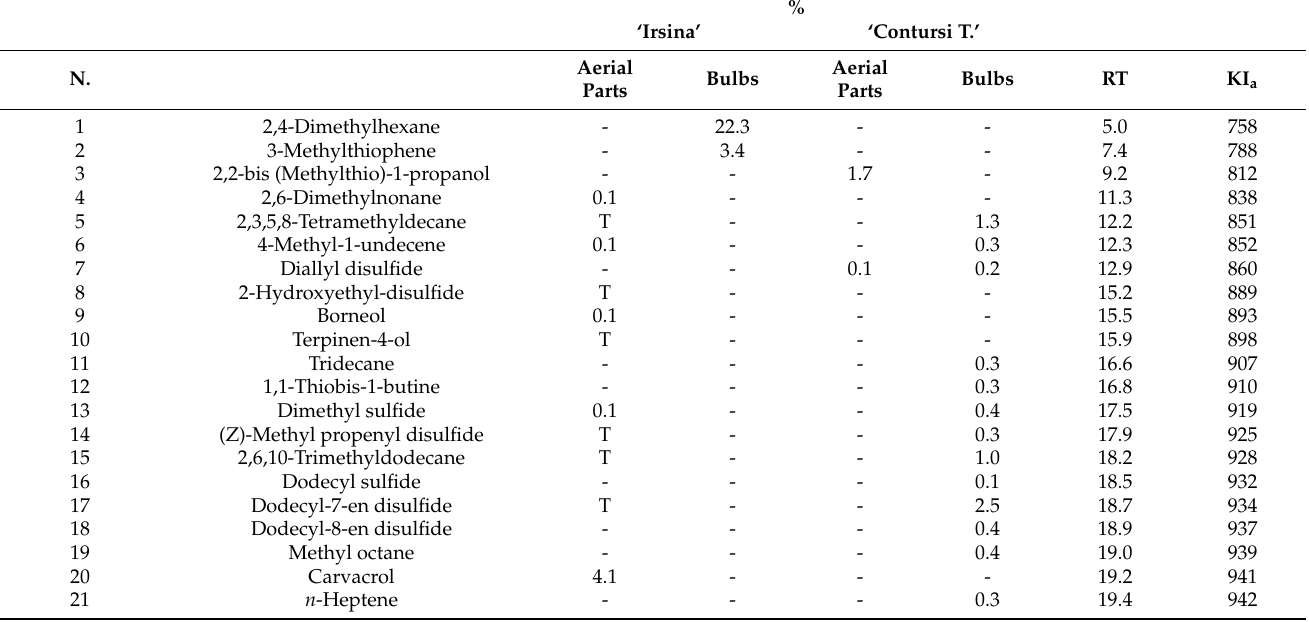
Table 2. Chemical composition of EOs from A. ampeloprasum var. holmense , cultivars ‘Irsina’ and ‘Contursi T.’. % ‘Irsina’ ‘Contursi